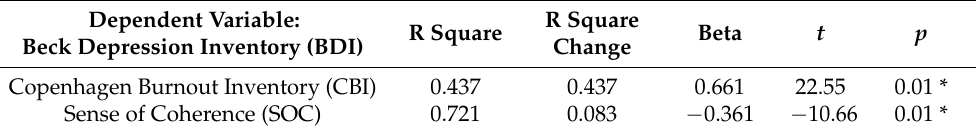
Table 3. Stepwise multiple regression (only statistically significant variables are included).